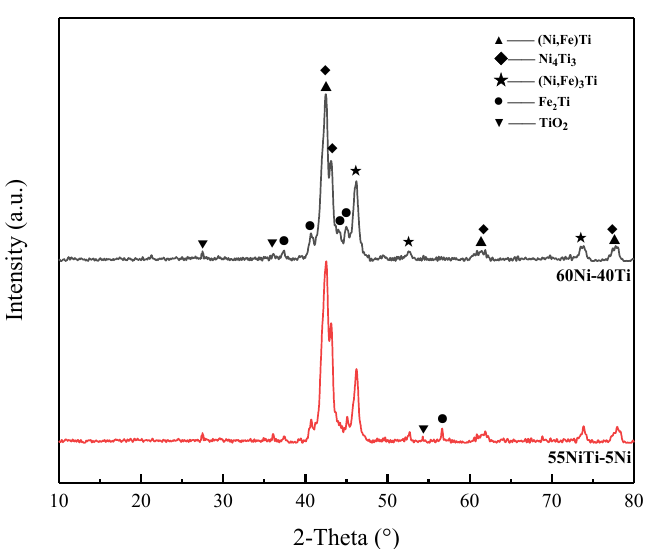
Figure 2. XRD patterns of coatings.